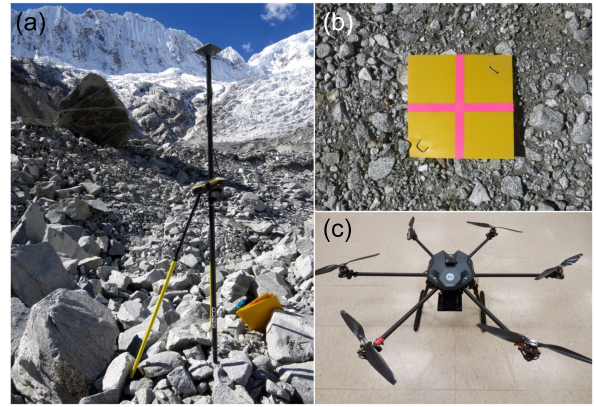
Figure 2. GNSS survey at Llaca Glacier (a) ; installed ground control target (2015) (b) ; hexacopter UAV platform used in this study (c)